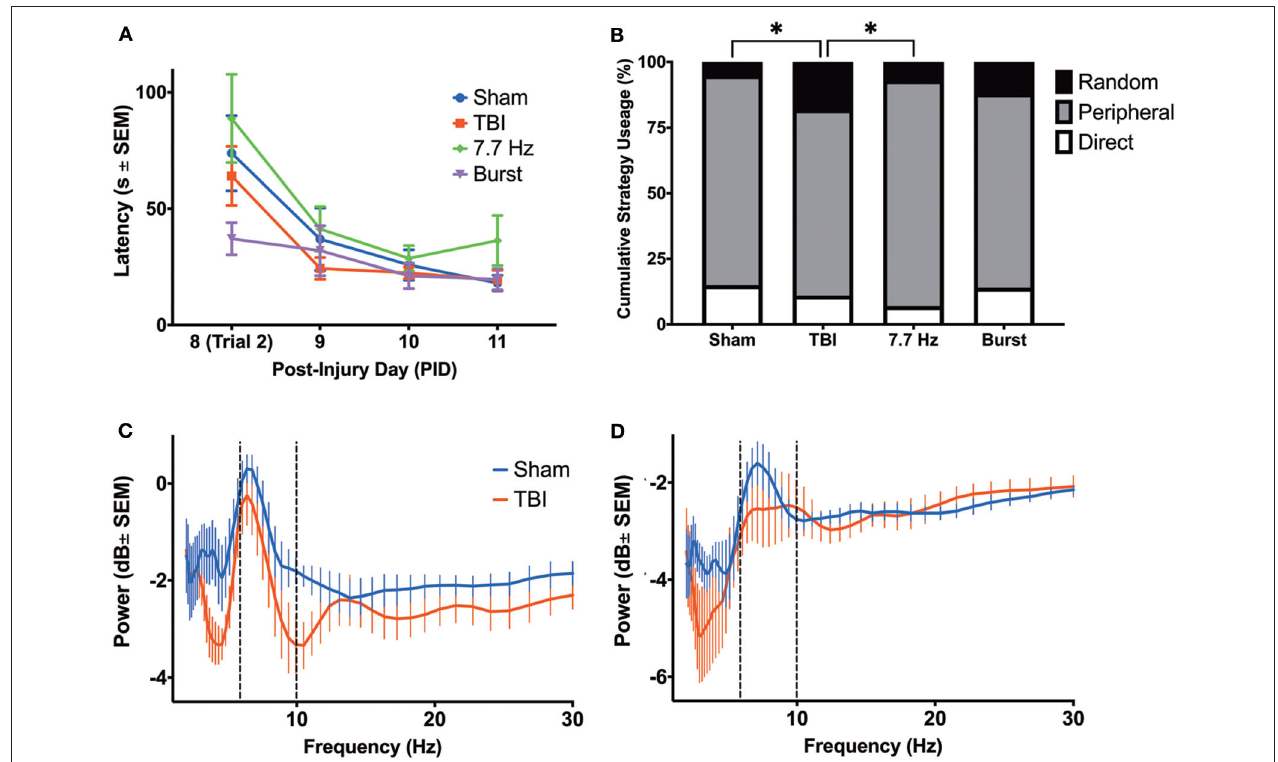
FIGURE 7 | Barnes Maze Performance did not reveal a Robust Cognitive Deficit in Injured Rats. (A) There were no differences between groups in latency to complete the task; (B) however, there were significant differences in cumulative search strategy. Specifically, TBI animals used a random strategy significantly more often than shams ( p < 0.05) and 7.7 Hz-stimulated animals ( p < 0.05). (C) There were no differences in the theta power between groups in the hippocampus or (D) ACC on PID 11, prior to final day of maze trials. All data are presented as mean ± SEM, * p < 0.05. Adapted from Paxinos et al.